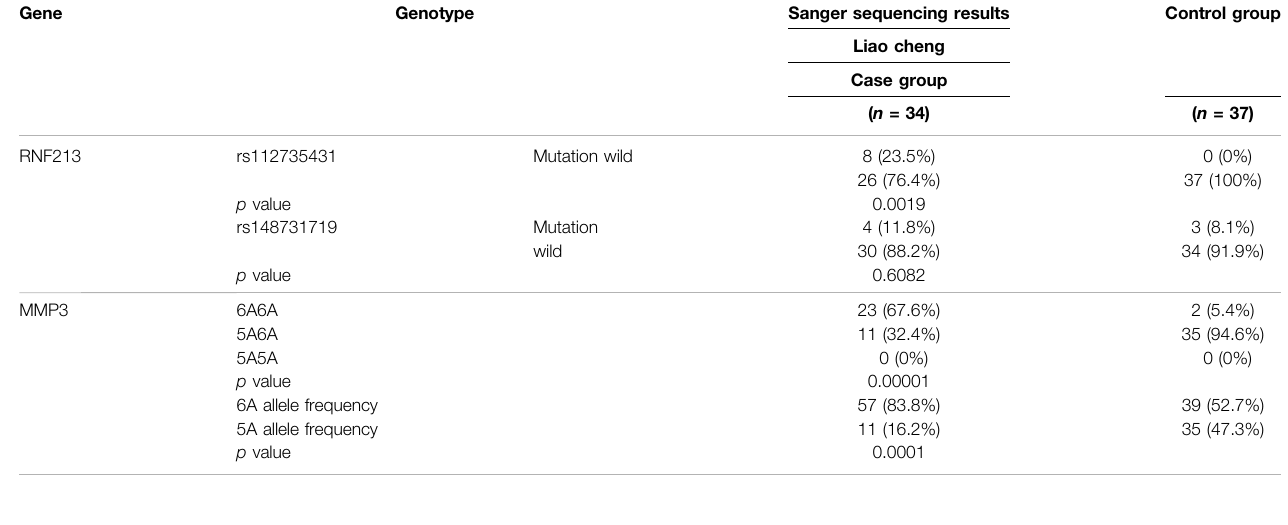
TABLE 5 | Analysis of RNF213 and MMP3 gene mutation.